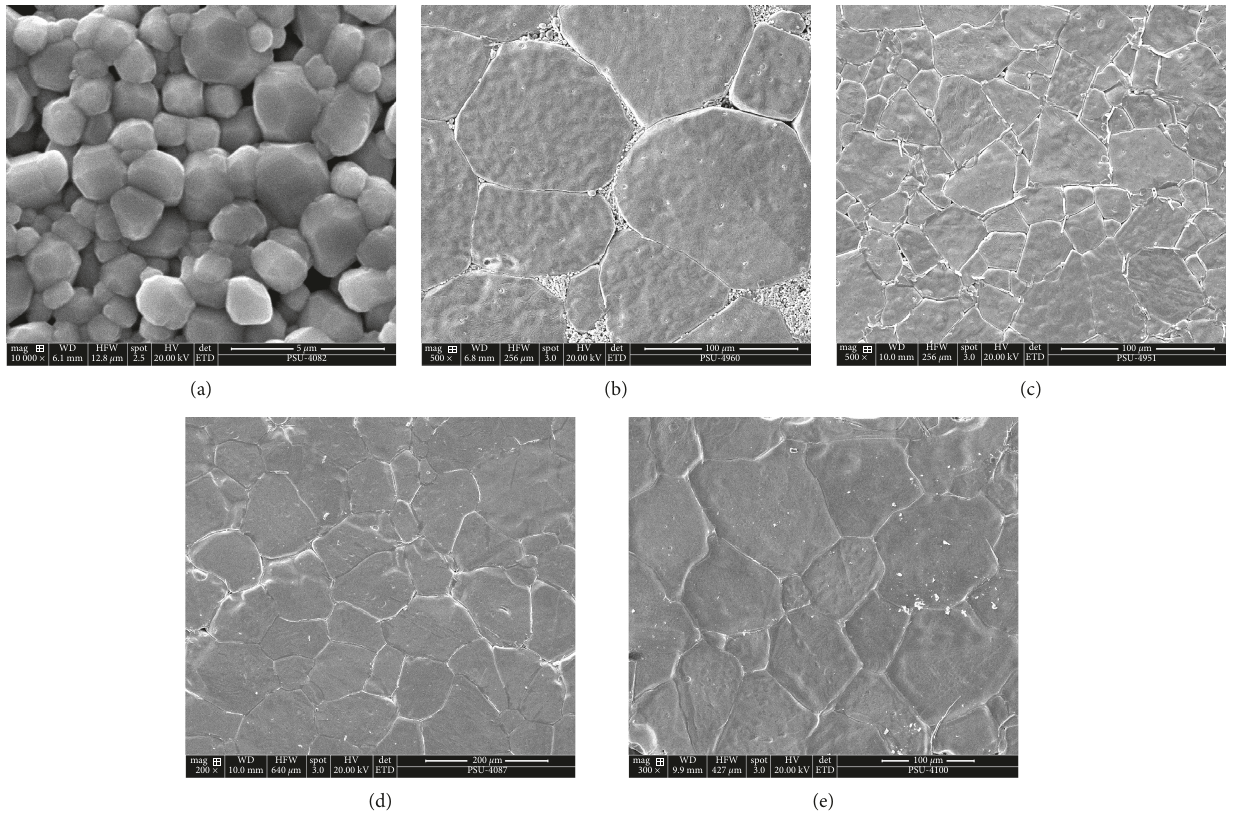
Figure 2: SEM micrographs of the BTS ceramics sintered under the various conditions: (a) “1400/15/1000/6”; (b) “1400/30/1000/6”; (c) “1500/0/1000/6”; (d) “1500/15/1000/6”; (e) “1500/30/1000/6”.